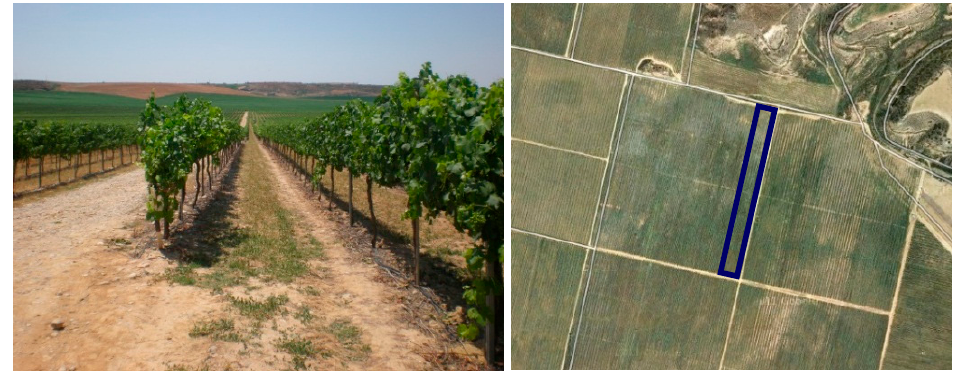
Figure 1. Plot of Vitis vinifera L. cv. Syrah ( left ), and location of the six rows scanned with the terrestrial laser scanner ( right ) [32]. The length of the vine rows is 360 m.